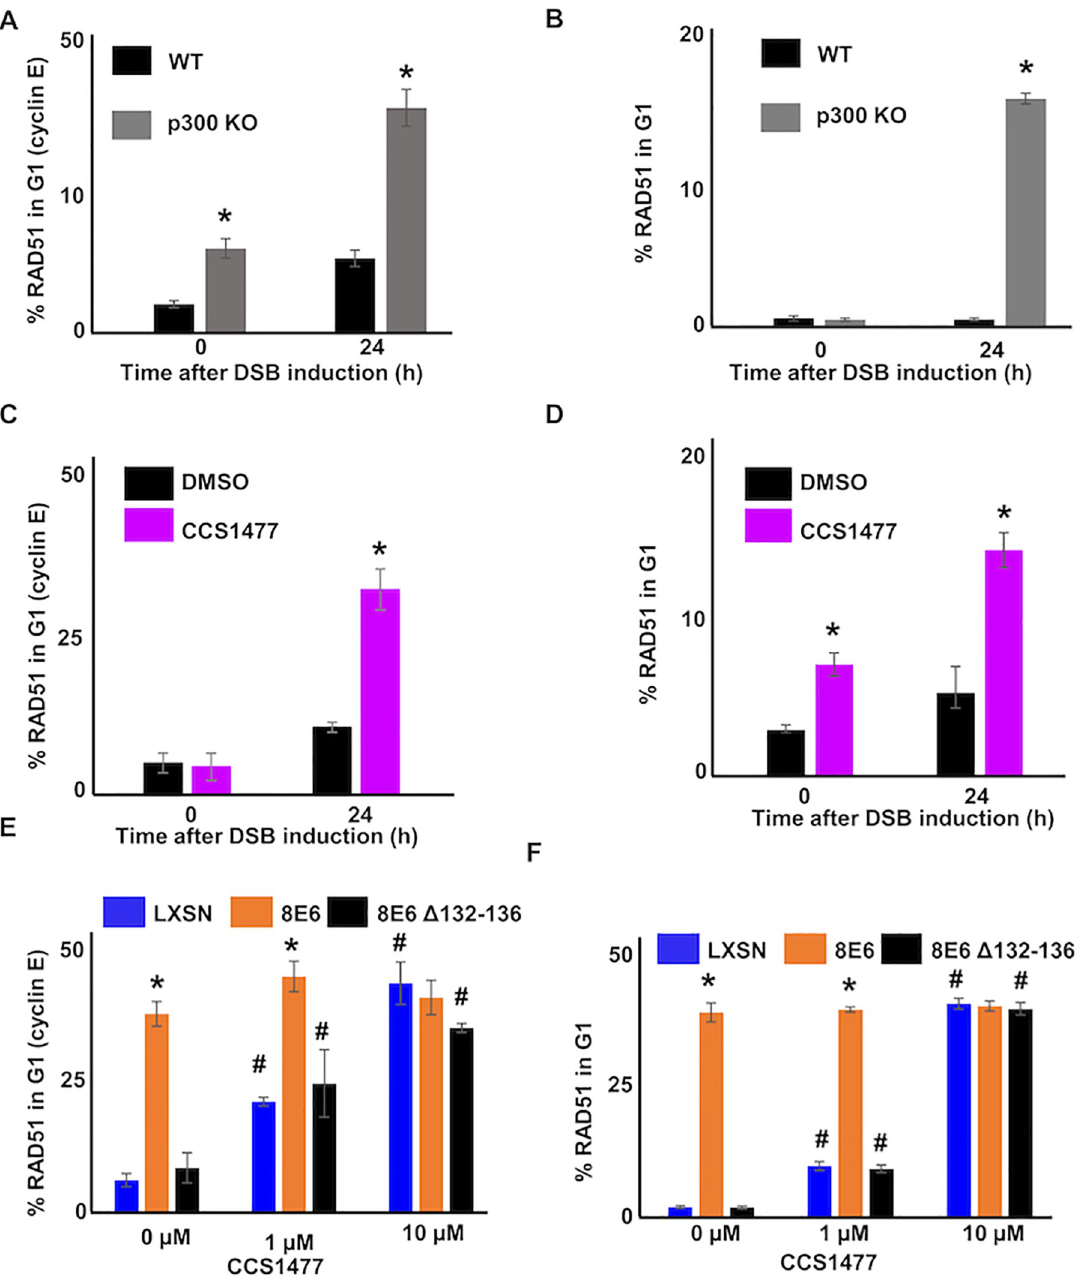
Fig 5. p300 restricts RAD51 foci formation in G1. (A-B) Percentage of HFK WT and HFK p300 KO cells with RAD51 staining in G1 as determined by (A) Cyclin E staining or (B) flow cytometry after zeocin treatment (10 μ g/mL, 10 min). (C-D) Percentage of HFK LXSN cells treated with DMSO or CCS1477 (1 μ M) that had RAD51 staining in G1 as determined by (C) Cyclin E staining or (D) flow cytometry after zeocin treatment. (E-F) Percentage of primary HFK LXSN cells treated with DMSO or CCS1477 that had RAD51 staining in G1 as determined by (E) Cyclin E staining or (F) flow cytometry after zeocin treatment. All values are represented as mean ± standard error. The statistical significance of differences between cell lines or treatments were determined using Student’s t-test. � indicates significant difference between two groups (A-D) or LXSN and 8E6 (E-F) with same treatment (p < 0.05). # indicates p < 0.05 between control (solvent) and treated group within each cell line. At least 150 cells were counted over three independent experiments for microscopy. Twenty thousand cells were counted for each of three independent flow cytometry